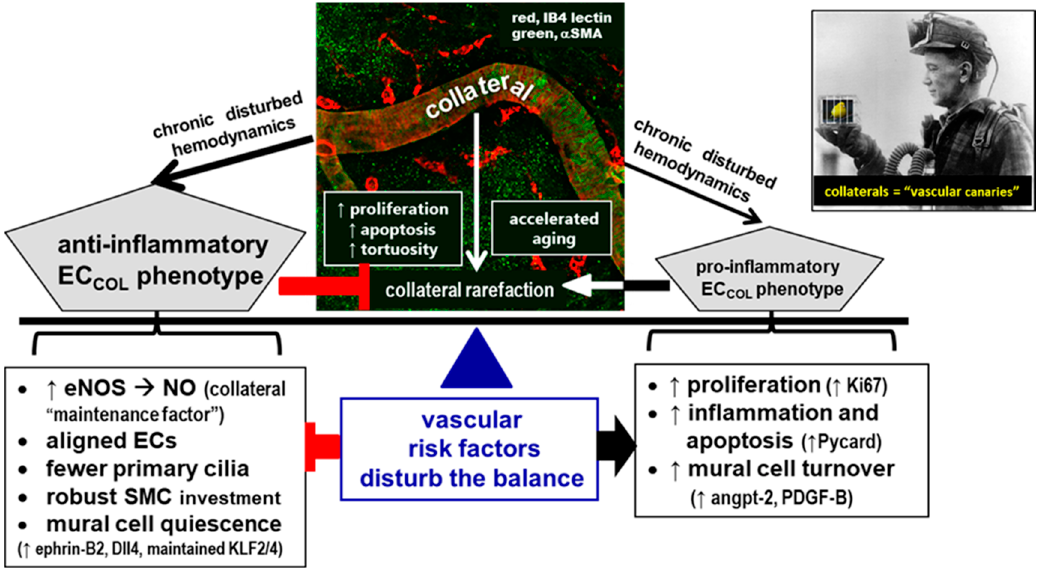
Figure 9. Persistence/maintenance versus rarefaction/pruning of collaterals “hangs in the balance”. Proposed model whereby collateral (COL) mural cells reside in an environment of low/disturbed shear stress, high circumferential wall stress, and low blood oxygen content. This favors a pro-inflammatory, pro-proliferative, pro-apoptotic, and accelerated aging EC phenotype, leading to loss of collateral number and diameter (rarefaction). Compared to distal arterioles, collaterals have specializations and differential gene expression (left box) that provide adaptations that mitigate against factors that promote collateral rarefaction (right box). Vascular risk factors, e.g., aging, hypertension, EC dysfunction, and oxidative stress, disturb the balance. Collaterals are more sensitive than other vessels to these environmental risk factors, like “canaries in a mine-shaft”.